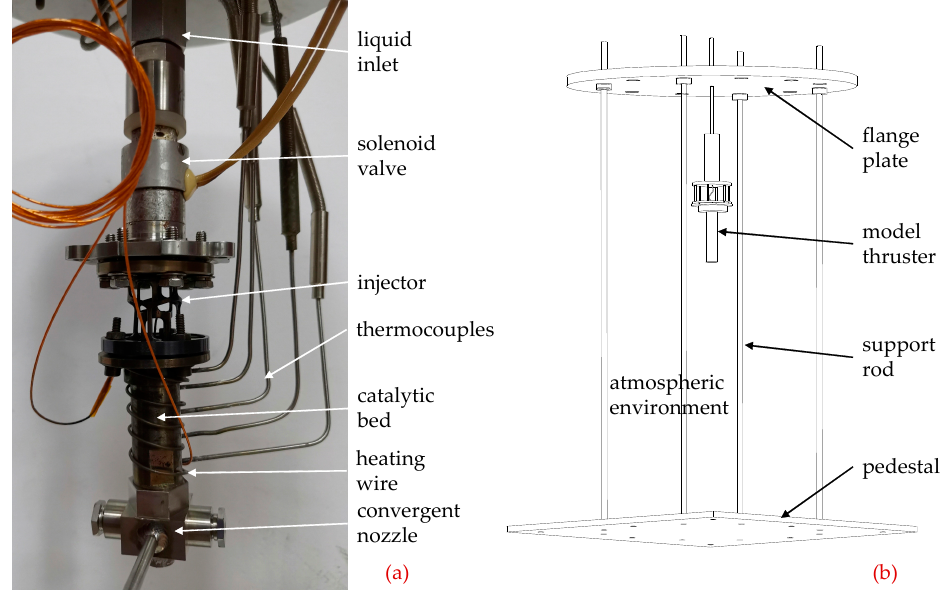
Figure 1. Model Thruster and experimental Setup: ( a ) model thruster; ( b ) experimental